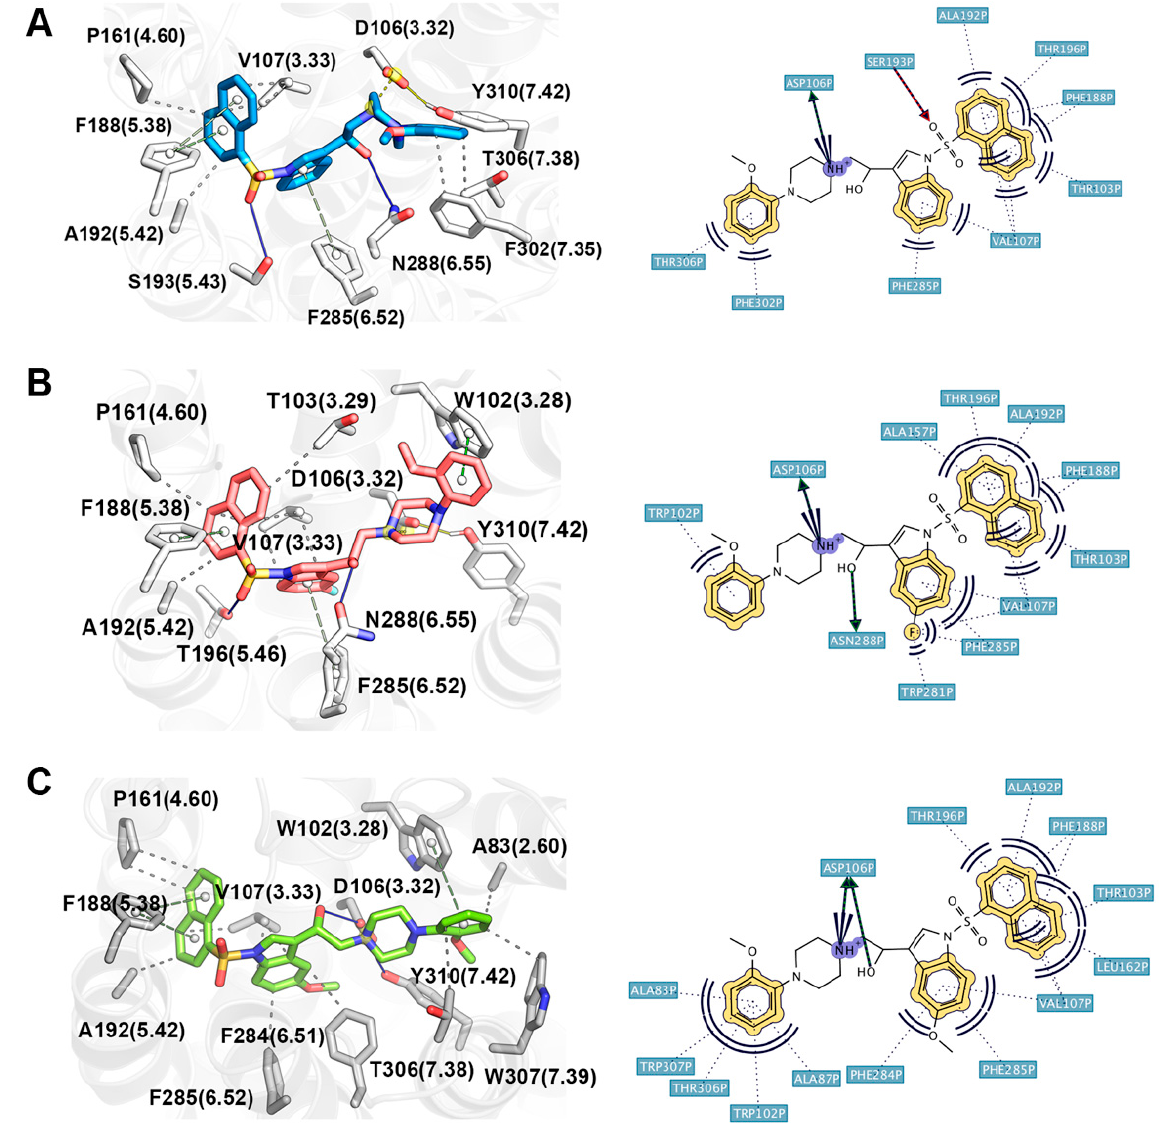
Figure 3. Binding modes obtained after MD simulation of compounds ( A ) PUC-10 (sky-blue), ( B ) 4d (deep salmon) and ( C ) 4l (lemon) depicted from the extracellular view. The 2D interaction plots were obtained with LigandScout v4.2 (Inte:Ligand GmbH).